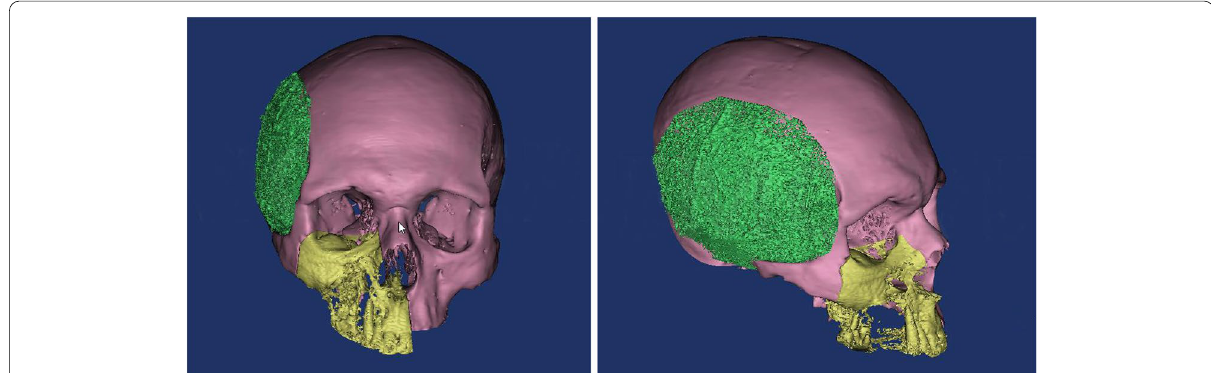
Fig. 1 The temporalis muscle virtually segmented and separated (green)